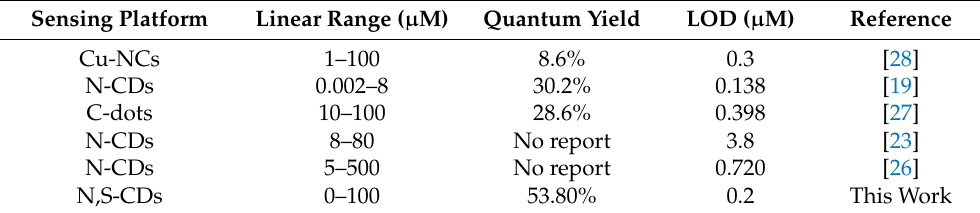
Table 1. Performance comparison of the different detection ranges and detection limits of carbon dots in the